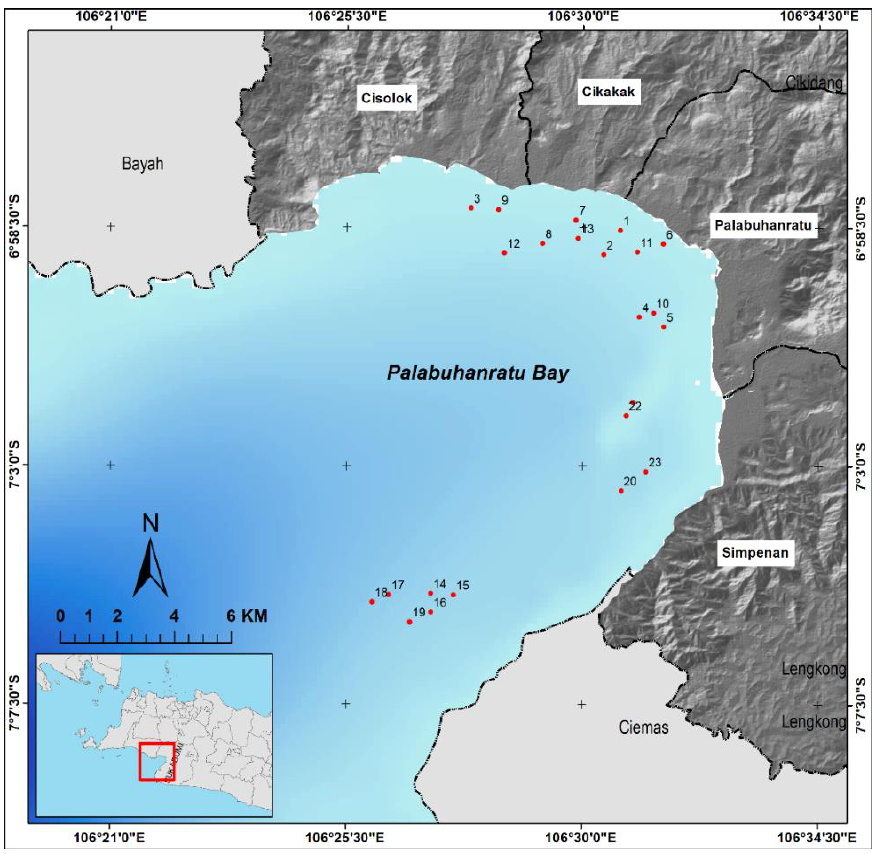
Figure 1. Research location. Red dots show the collected lobster catch points.